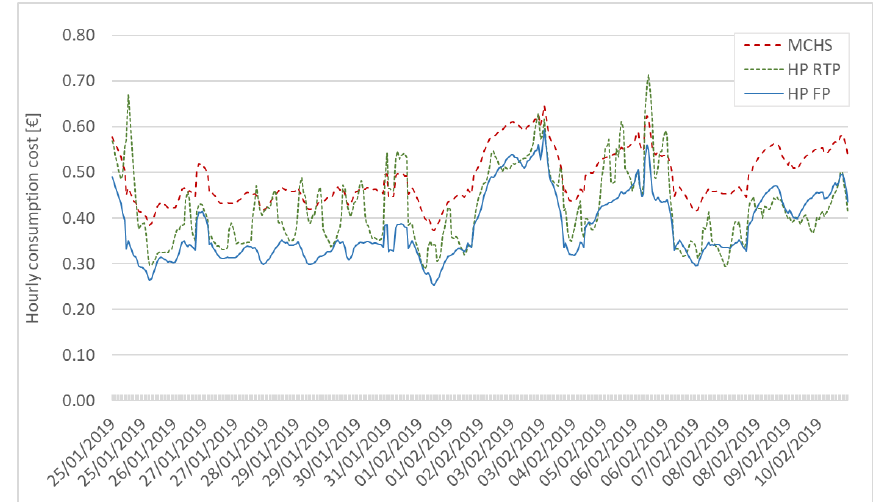
Figure 3. Hourly consumption cost for the district heating and both flat and real time price tariffs.